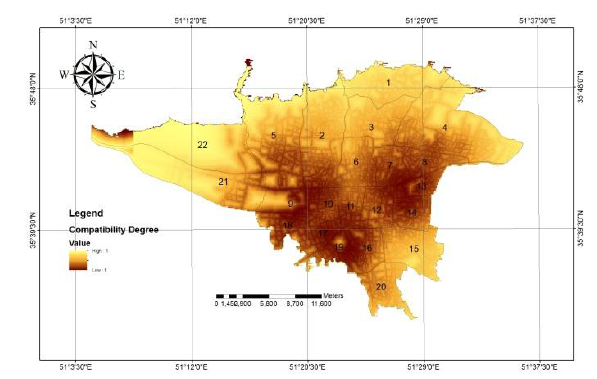
Figure 4. Land use compatibility map for elementary